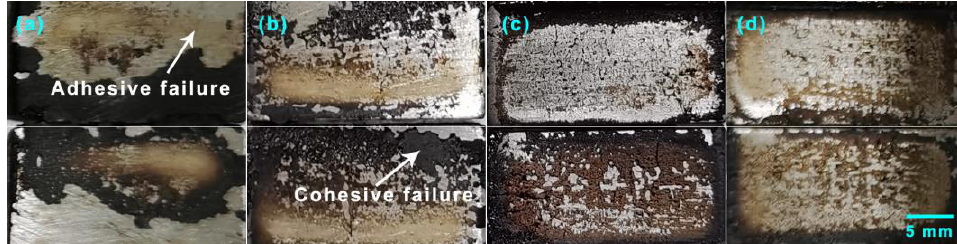
Figure 13. Failure surfaces of steel plates bonded with GNP-reinforced EABCs: EABC ( a ), 0.2% ( b ), 0.5% ( c ) and 1.0% ( d ) after single-lap shear tests at room temperature.